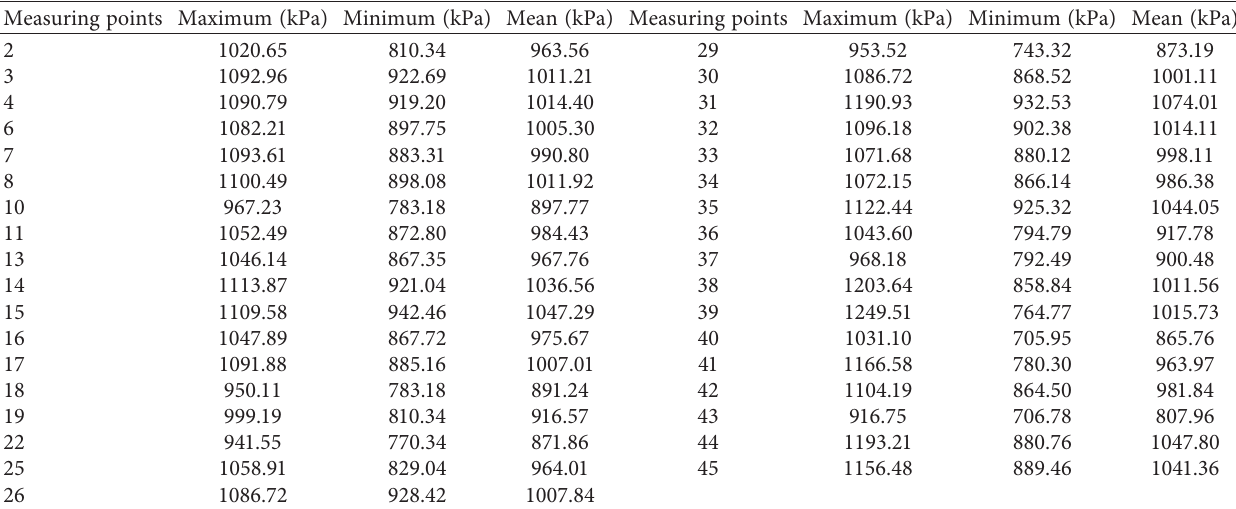
Table 1: Peak values and mean values of measuring points.